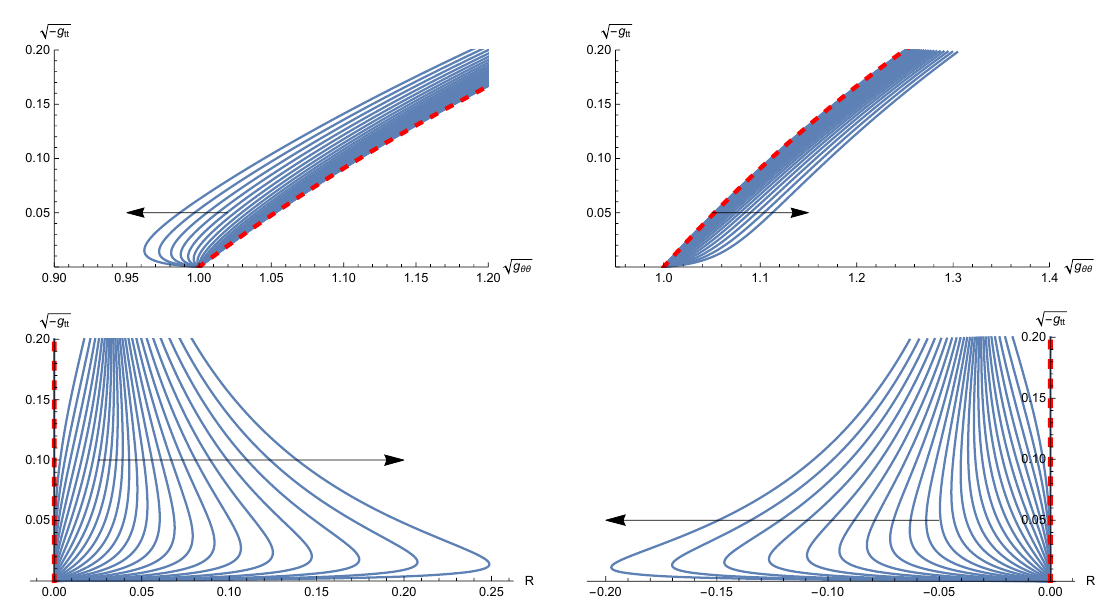
Figure 12 . The top panels are similar to the previous figure, but now the two flows depicted are for an initial small perturbation of extremal electrically charged RN that preserve the horizon geometry so that the near horizon geometry remains that of extremal RN throughout the flow. The perturbation to RN in equation (6.18) with negative and positive sign generates the top left and right panels respectively. In both cases the flow time interval between the curves is ∆ λ = 0 . 1 . While the horizon geometry is fixed, we still see extremal RN is unstable as the perturbation grows in the exterior. This appears to build up curvature near, but not at, the horizon. This is confirmed in the √ bottom two panels, where the Ricci scalar is plotted against − g tt , the left frame being for the negative sign perturbation, the right for positive. This is zero for the RN solutions, and is fixed to zero at the horizon as the near horizon geometry is unperturbed here, but we see it appears to grow in the vicinity of the horizon. The curves are plotted up to a flow time λ = 2 . 5 when gradients start to become too large to accurately resolve. While it appears a singularity forms, it remains unclear whether this occurs in a finite flow time.